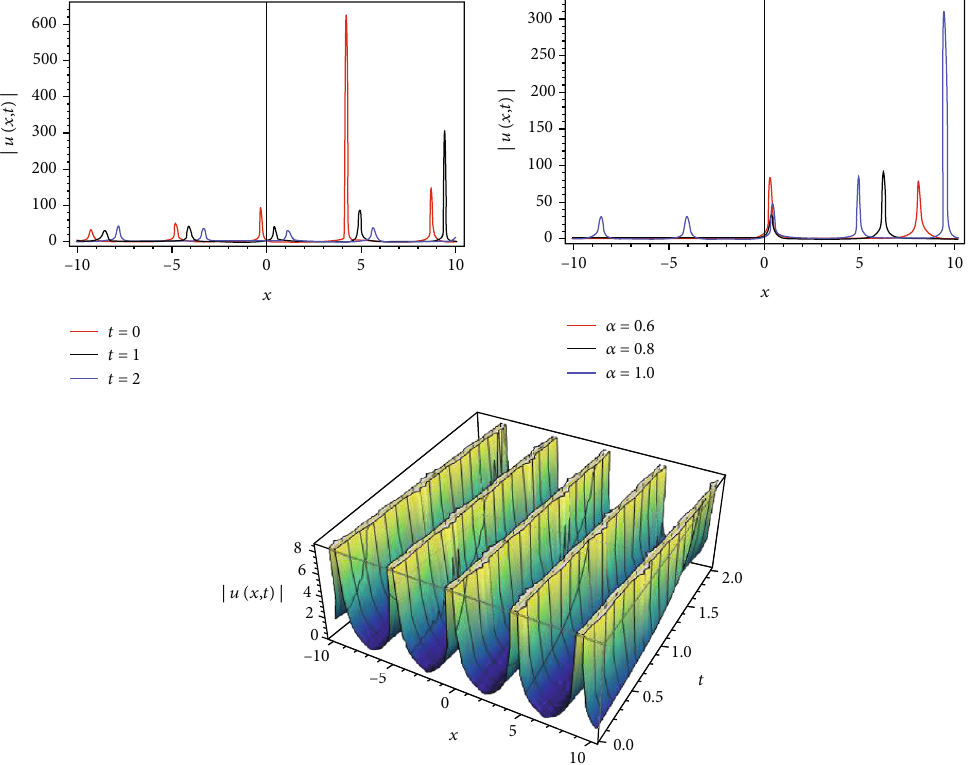
Figure 4: 2D and 3D graphics of Case 2 for trigonometric traveling wave solution (31) at f α = 0 : 6, p = 0 : 7, q = 1, s = 1, C = − 1, c = 0 : 5 g